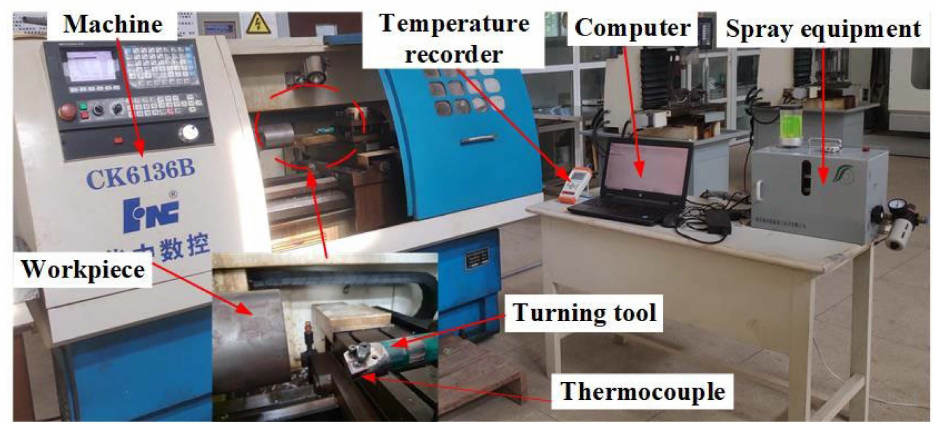
Figure 11. Internal turning experimental platform.